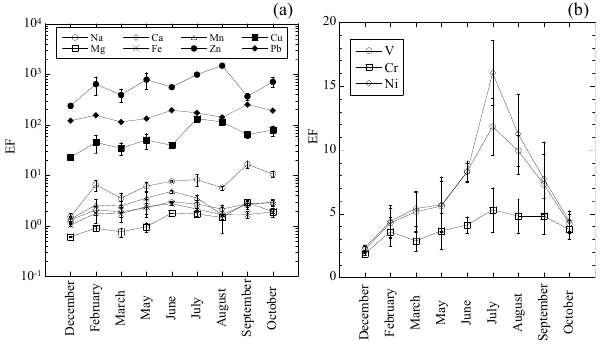
Fig. 4. Enrichment factor (EF) of each element in aerosol at Tsukuba for (a) Na, Mg, Ca, Fe, Mn, Zn, Cu, and Pb; (b) EFs of V, Cr, and Ni. Error bars are standard deviations obtained by three independent experiments.